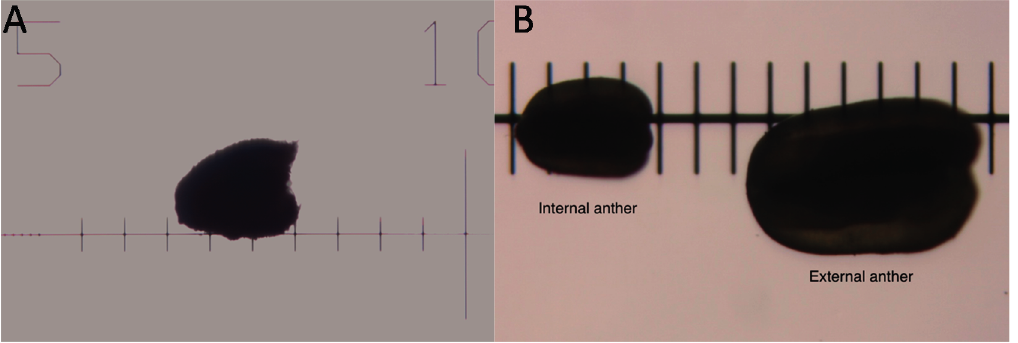
Figure 1. Illustration of how the measurements of floral bud ( A ) and anthers ( B ) were taken using a glass stage micrometer. Each division is 1 mm in ( A ) and 0.1 mm in ( B ). These pictures were taken in the light field, but measurements were typically taken in the dark